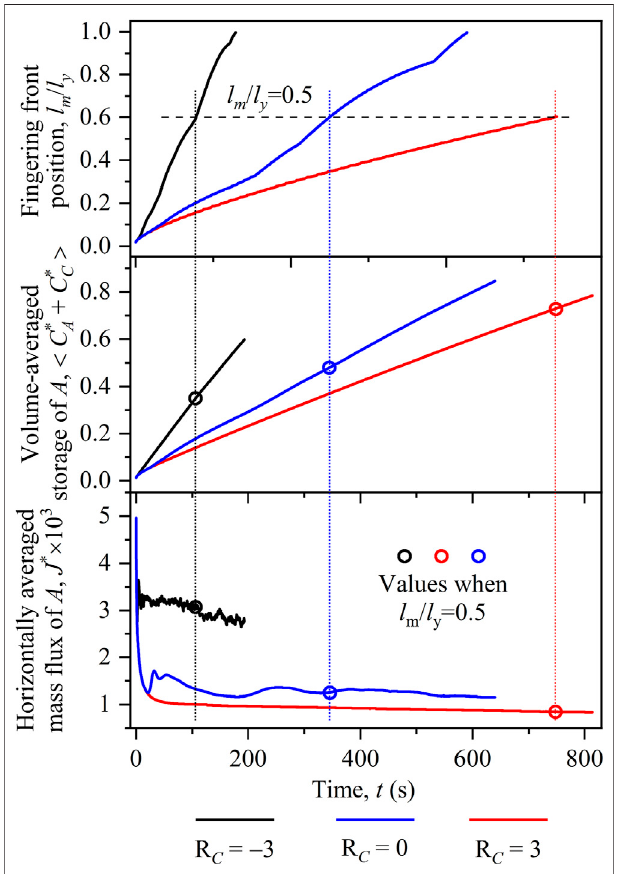
FIGURE 5 | Temporal evolutions of (A) front position l m / l x , (B) volume- averaged storage of A in the host fl uid 〈 C * A + C * C 〉 , and (C) horizontally averaged mass fl ux of A at the top boundary J * for cases with Ra AB (cid:2) 1, Ra CB (cid:2) 1, R A (cid:2) 0, and R C (cid:2) − 3, 0, 3.